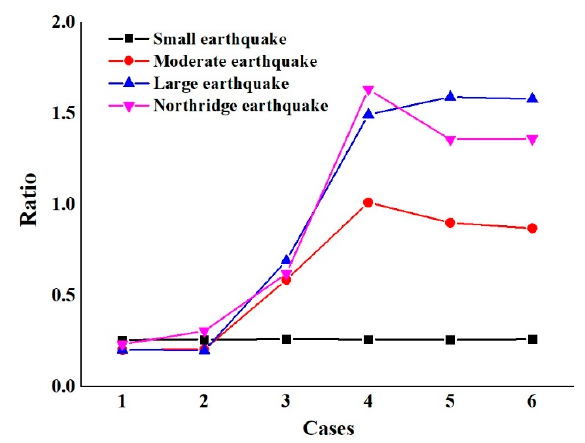
Figure 11. Moment ratio at pier bottom.